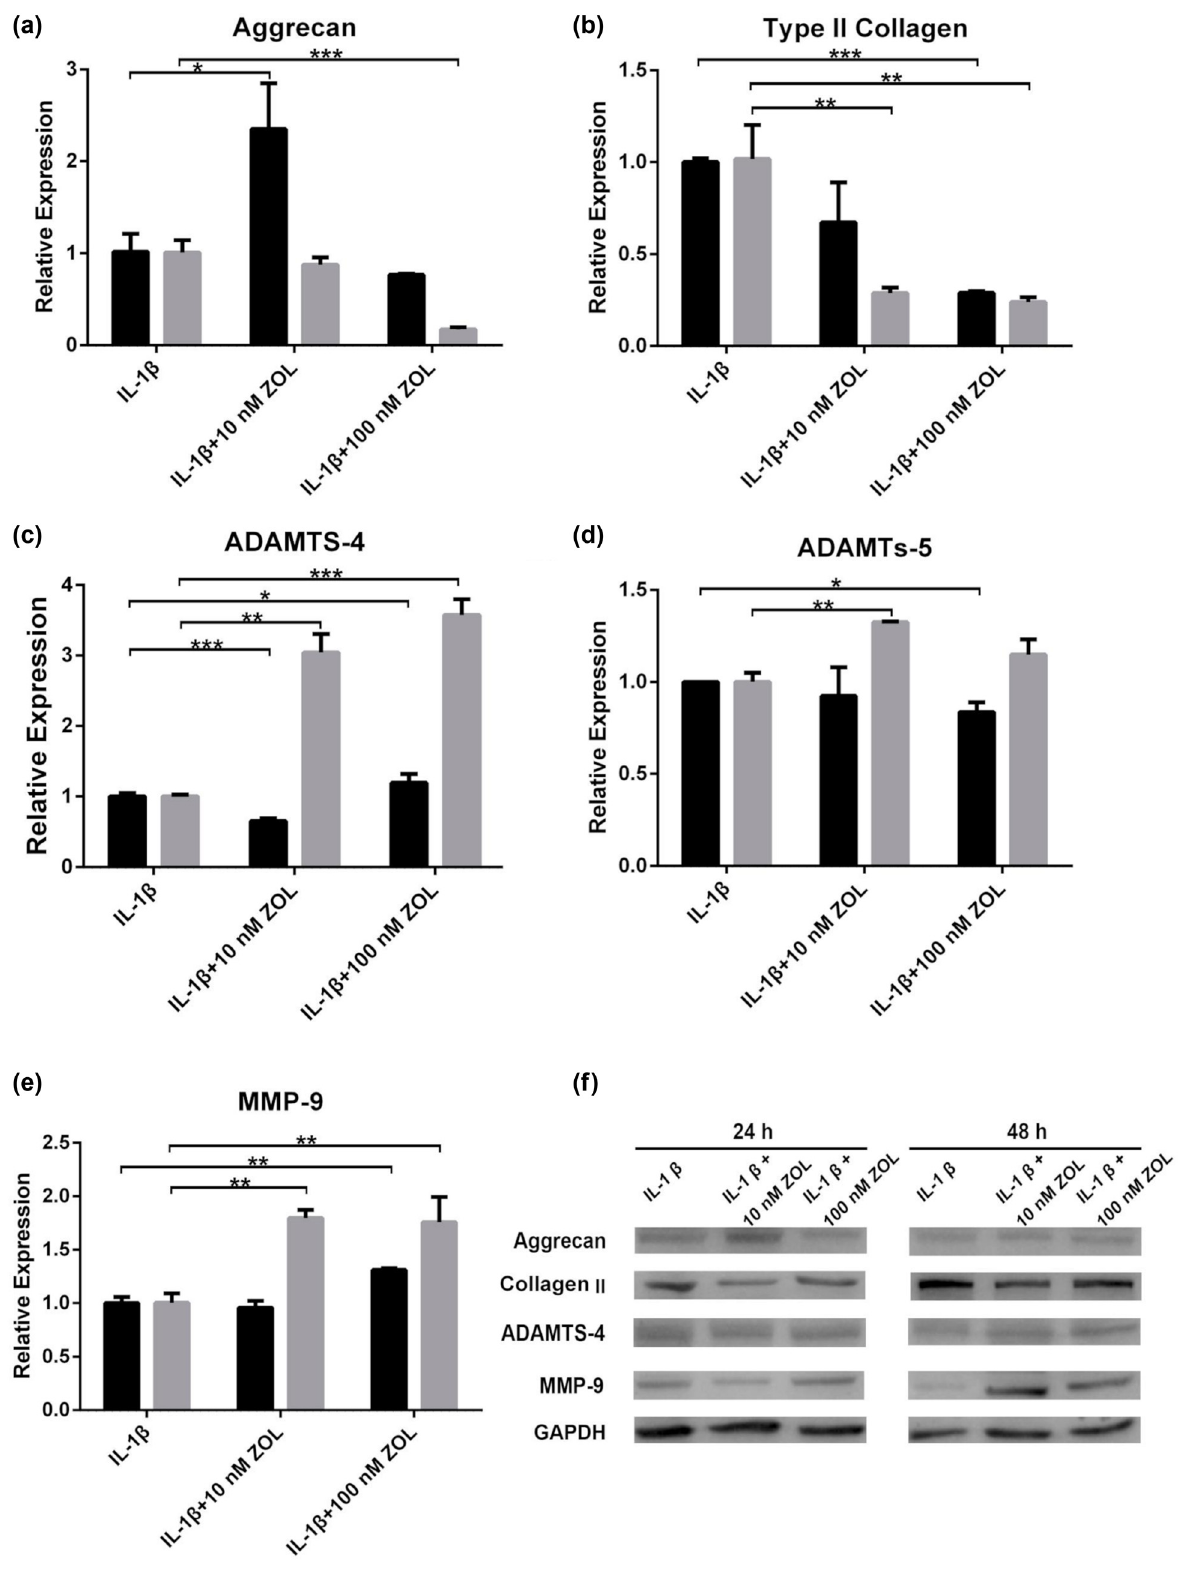
Figure 3: Expression levels of ECM - related genes and proteins after treatment with 10 or 100 nM ZOL in TMJOA chondrocytes. ( a ) Aggrecan, ( b ) type II collagen, ( c ) ADAMTS - 4, ( d ) ADAMTS - 5, and ( e ) MMP - 9 were analyzed by qRT - PCR. ( f ) ECM - related proteins were detected by western blotting. Black bars represent the control group, and gray bars represent the 10 ng/mL IL - 1 β group. All data are presented as mean ± SEM. * p < 0.05, ** p < 0.01, *** p < 0.001 between the two groups linked by the line; all other comparisons are not signi fi